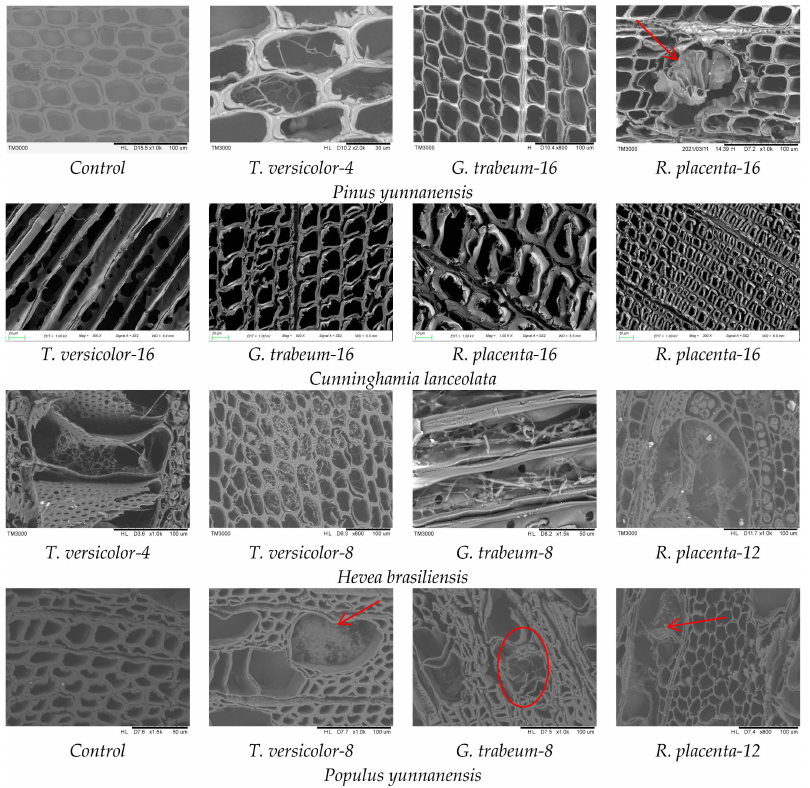
Figure 5. SEM images of wood samples biodegraded by different